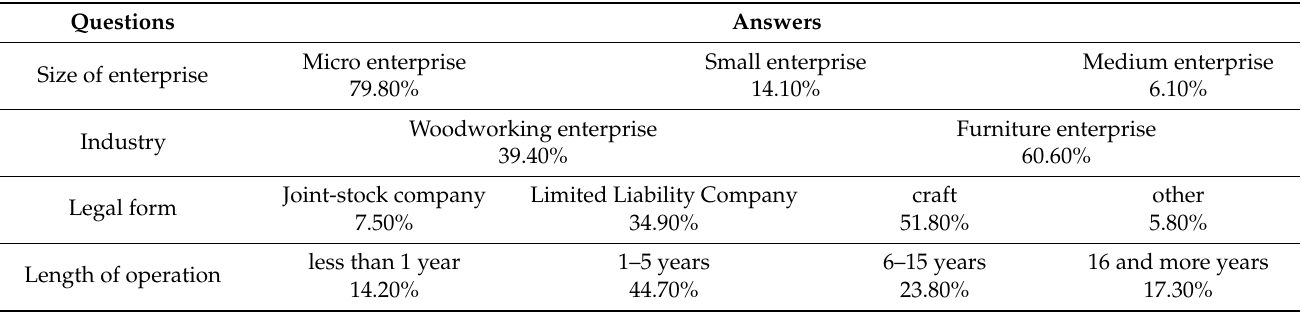
Table 1. Identification marks of the Slovak MSM WFEs (answers to questions A1–A4).